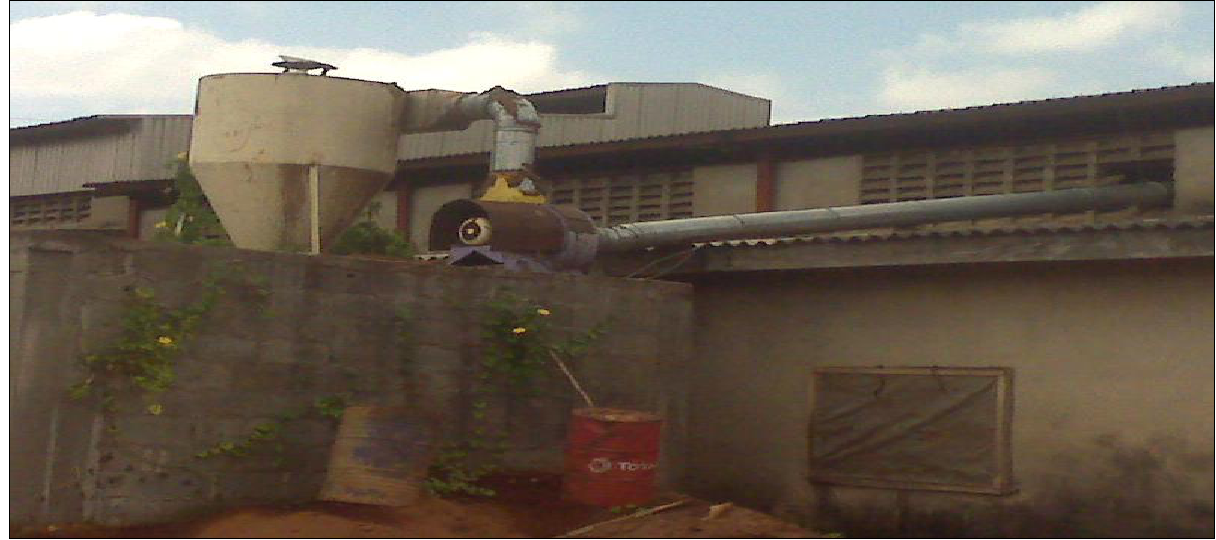
Fig. 9. Saw dust waste by vertical band saw (left) and dust collection hood (right)